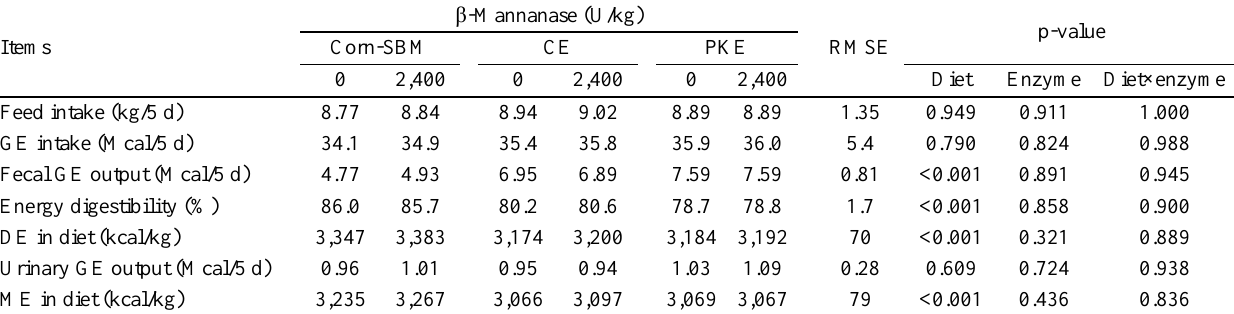
Table 3. Effects of supplemental β-mannanase on digestibility of corn-soybean meal-, copra expellers-, or palm kernel expellers-based diets fed to pig 1,2